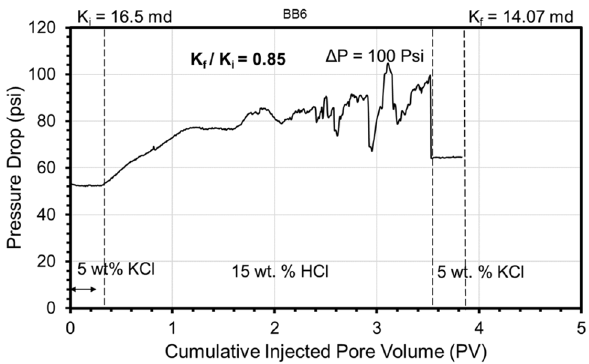
Fig. 6 Pressure drop across the sample Bandera Brown sand- stone (BB6) as the 15 wt% HCl injected at 5 cm 3 /min (backpres- sure = 1000 psi, confining pressure = 1700